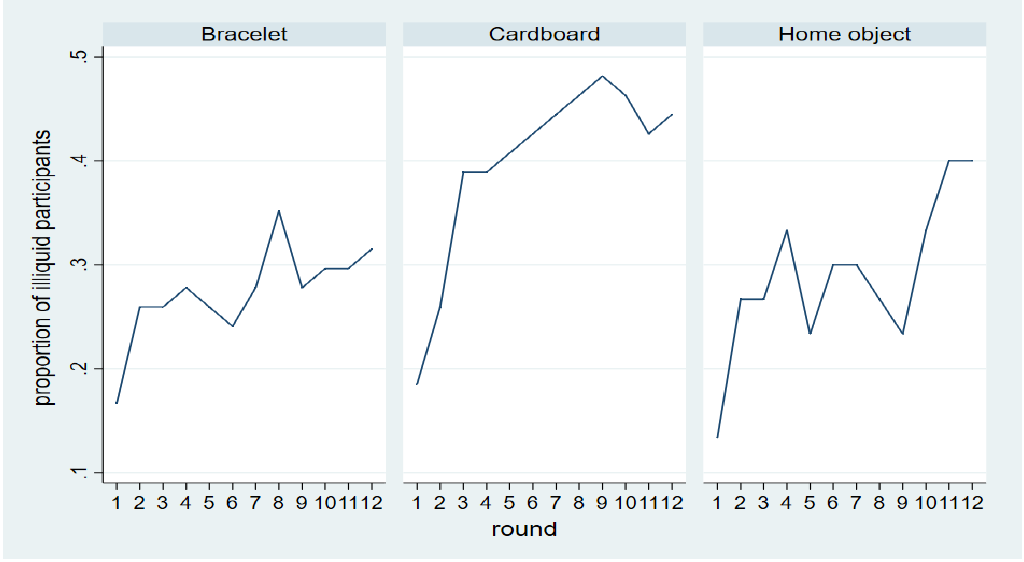
Figure 4. The proportion of illiquid participants in each round.